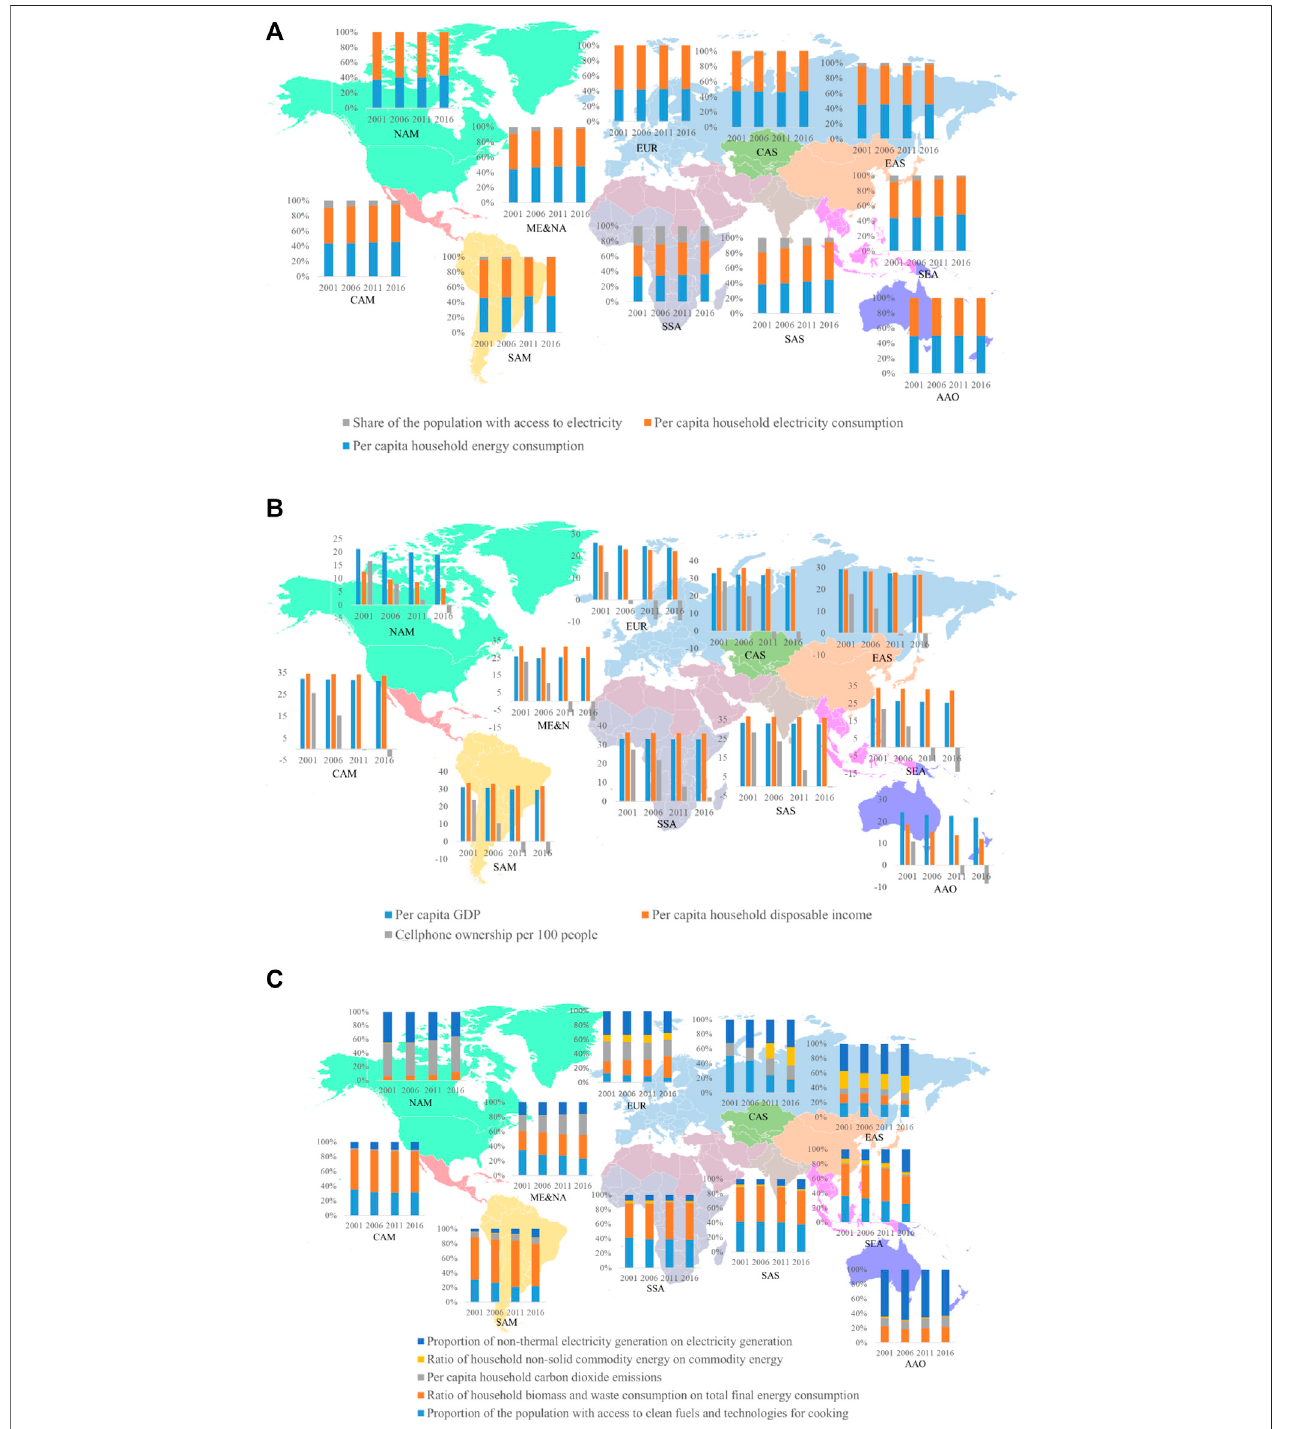
FIGURE 4 | Structure of dimension indices at the regional level in 2001, 2006, 2011, and 2016. (A) D1 (energy availability). (B) D2 (energy affordability). (C) D3 (energy ef fi ciency).